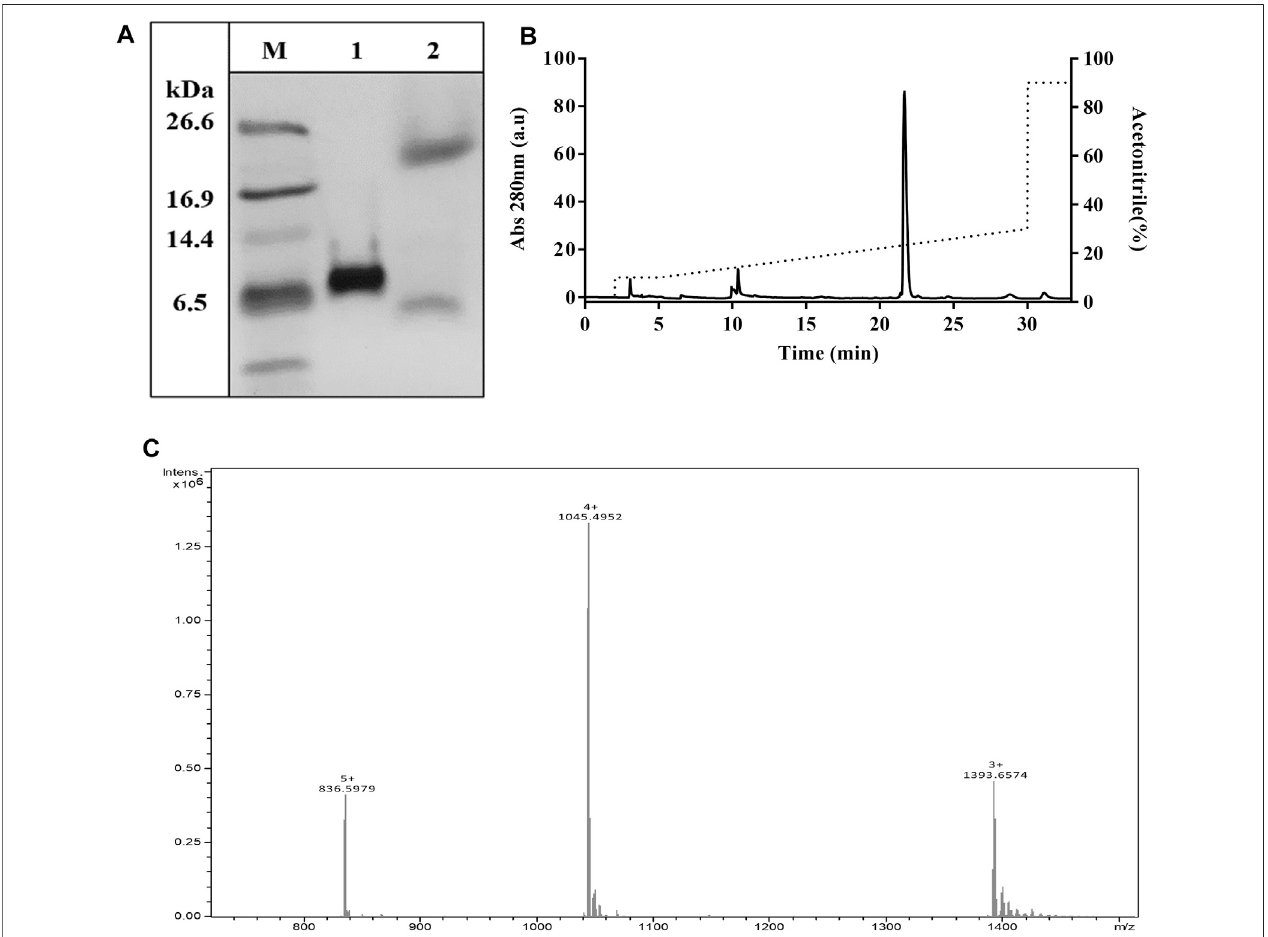
FIGURE5| RemovaloftagfromTrMgTx. (A) 16%Tricine – SDS-PAGEanalysisoftheTrMgTx samplesincubated overnightat25 ° Cwithout( lane1 )and with( lane 2 ) factor Xa protease (at 1:200 enzyme to peptide ratio); M : low-molecular-weight protein marker. (B) RP-HPLC chromatogram shows the puri fi cation of UrMgTx. After separating the His-tag fragments with Ni + beads, the digested sample was loaded on C 18 column and eluted with a gradient of 10 – 30% acetonitrile over 25 min. The absorbance was measured at 280 nm (left axis), dotted line shows the acetonitrile gradient (right axis). (C) ESI-QTOF-MS spectrum illustrates the average mass (4178.95 Da) of the puri fi ed